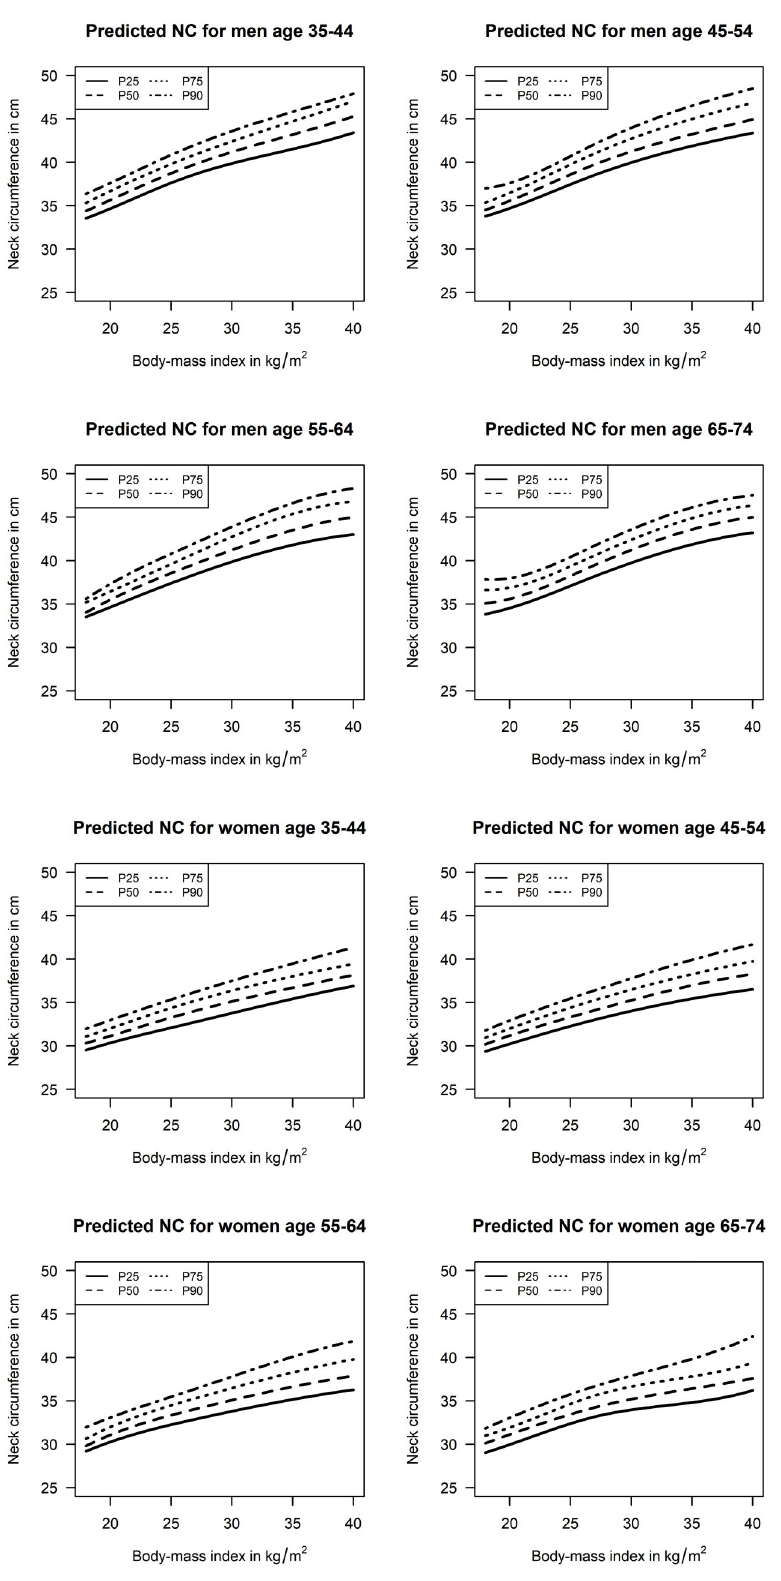
Figure 2. Predicted 25th, 50th, 75th, and 90th percentiles for neck circumference (NC) values according to age, body mass index, and